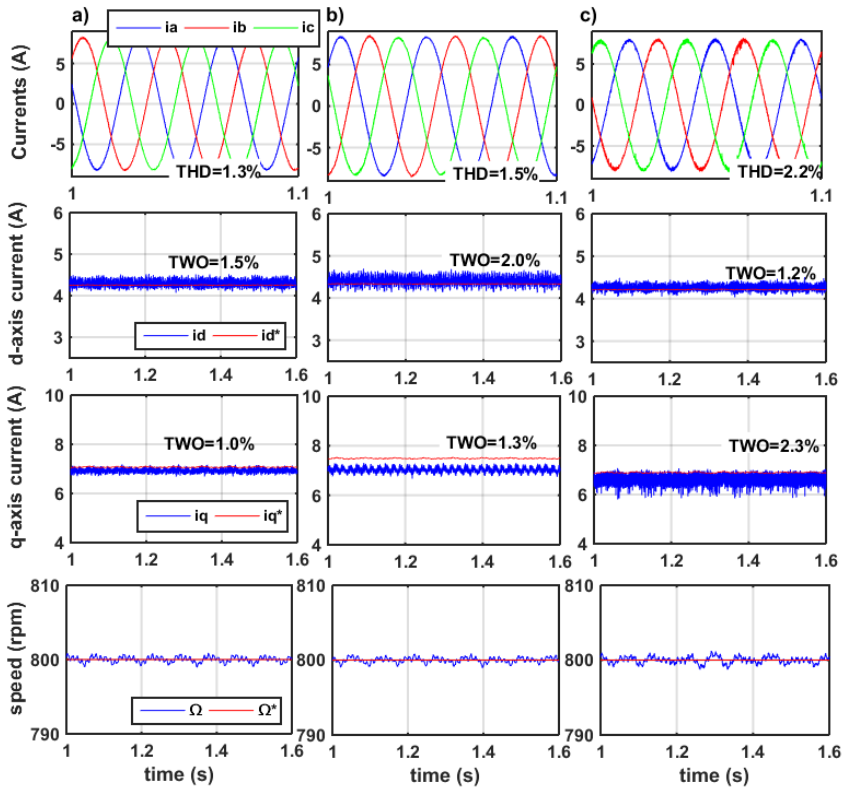
Figure 7. Experimental results for 800 rpm and 14 Nm: ( a ) MBPCC with nominal parameters, ( b ) MBPCC under the influence of parameter variations (0.5xLd, 0.5xLq), ( c ) proposed GW − MFPCC.